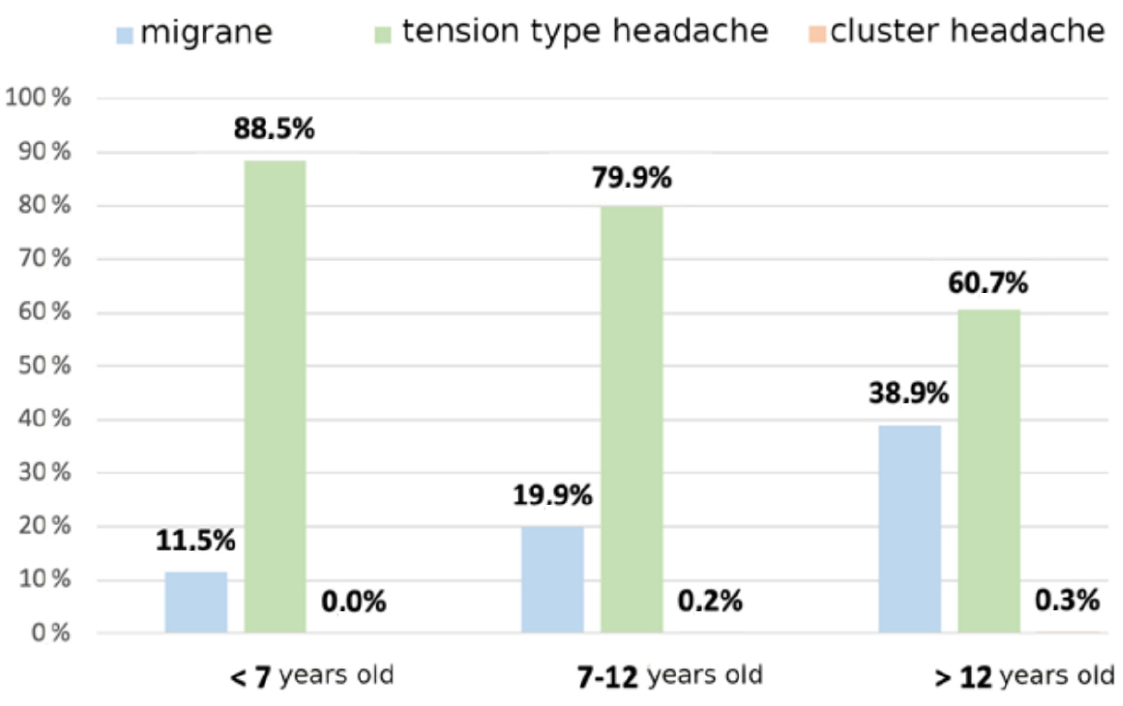
Figure 2. Age distribution of primary headaches.